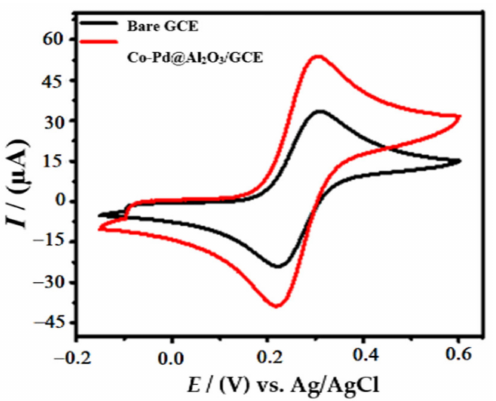
Figure 6. Cyclic voltammograms at bare GCE and Co–Pd@Al 2 O 3 /GCE in a 5 mM solution of K 3 [Fe(CN) 6 ] in 0.1 M KCl.